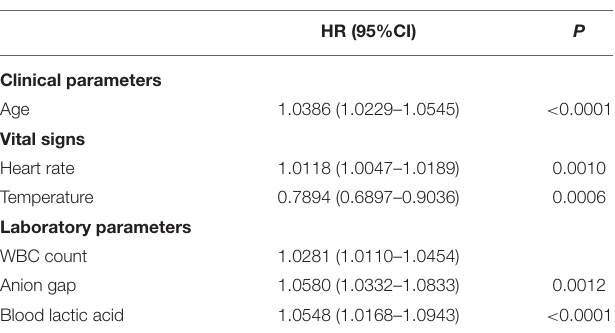
TABLE 2 | Cox regression model. TABLE 3 | LASSO regression